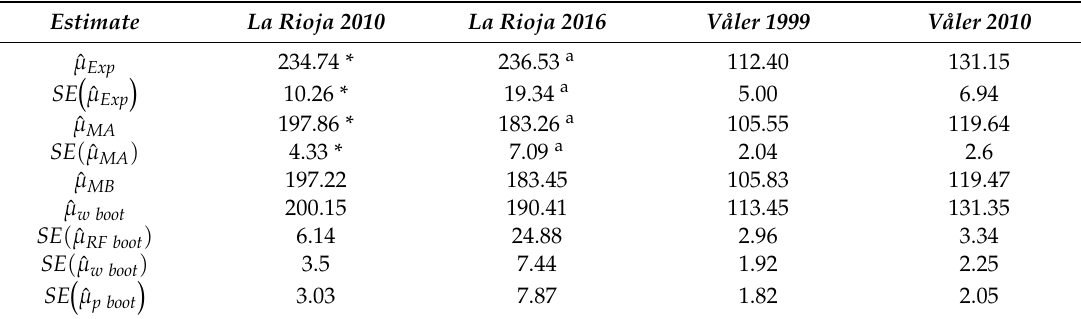
Table 2. Population estimates for both study